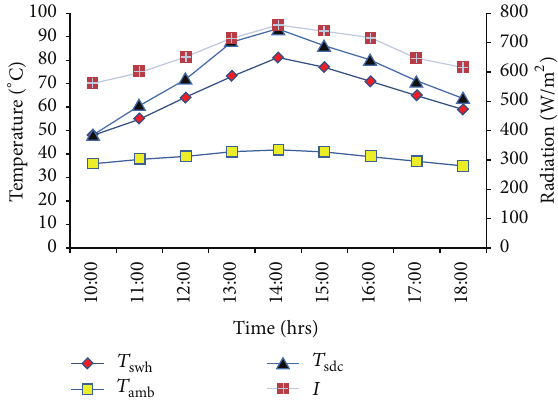
Figure 4: Performance curves of temperature variations during production of distilled